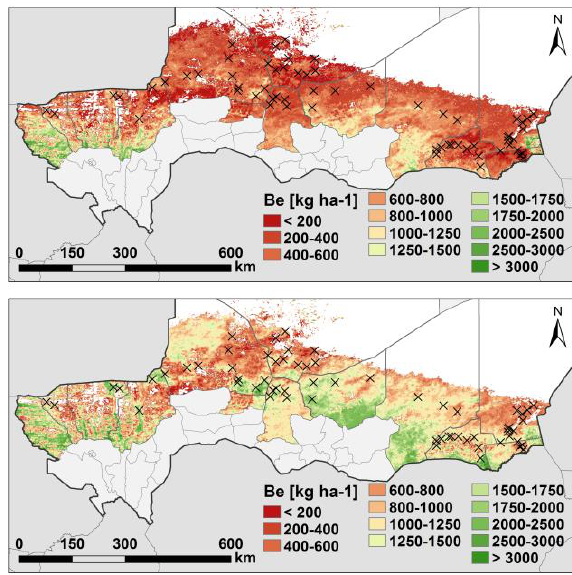
Figure 8. Estimated biomass in 2004 (top) and 2012 (bottom) based on linear regression model with department